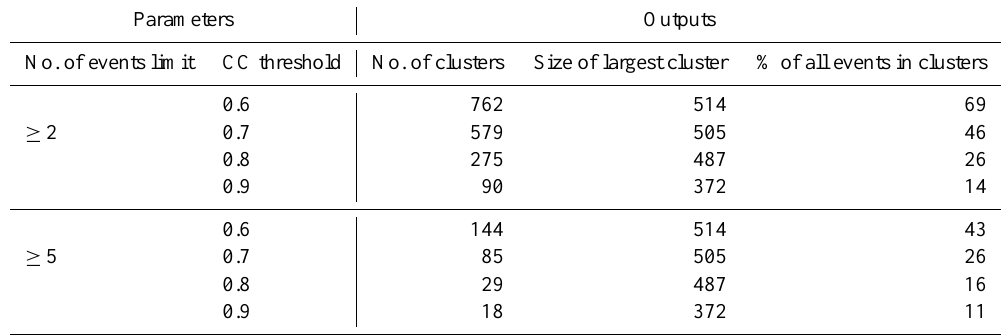
Table B1. Parameters used for waveform correlation and their output values using the 5738 events detected from 1 October to 15 Novem- ber 1994. CC stands for correlation